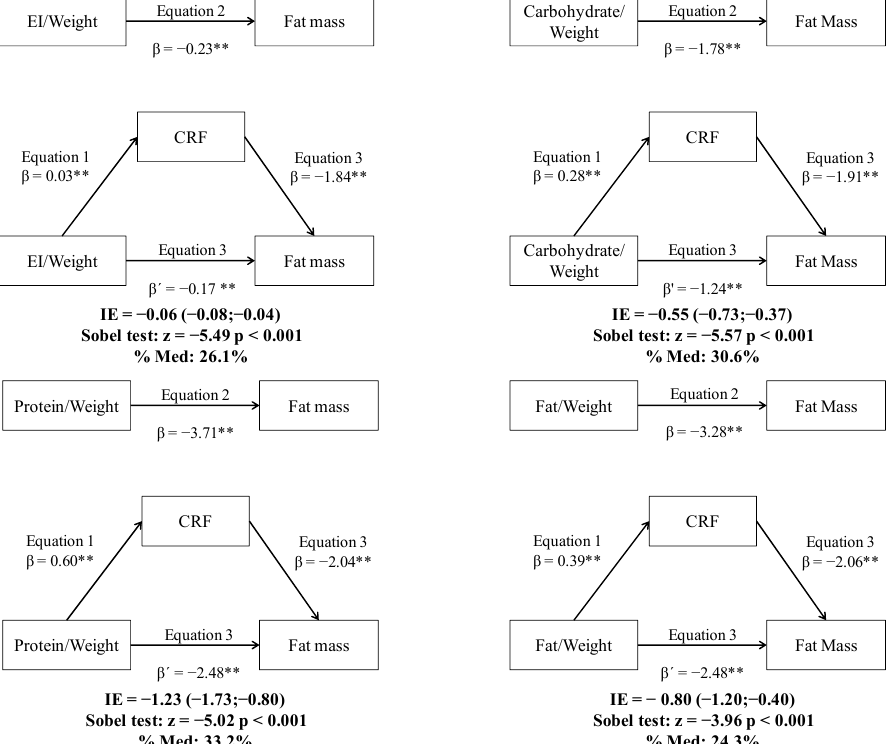
Figure 1. Simple mediation models of the relationship between dietary factors and fat mass, using CRF as a mediator, controlling for age. EI, energy intake; CRF, cardiorespiratory fitness; IE, indirect effect; %Med, percentage mediated by fat mass. ** p < 0.001.